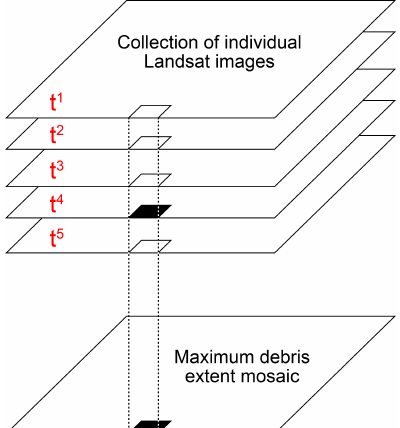
Figure 2. Reducer diagram – GEE stacks all images in the collec- tion and undertakes pixel-wise analysis of debris cover, to create a mosaic of maximum debris cover extent. If just one pixel in the im- age stack is debris, then the corresponding pixel in the maximum debris mosaic will be debris. White pixels represent snow and ice, and black pixels represent